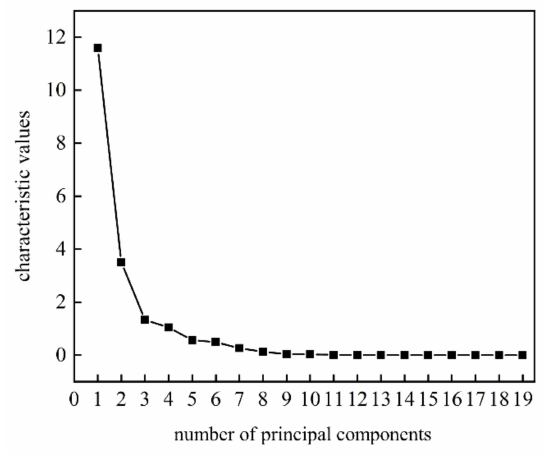
Figure 3. The gravel map of the principal components scores to the fusion of E-nose and E-tongue for freshly squeezed strawberry juice during cold